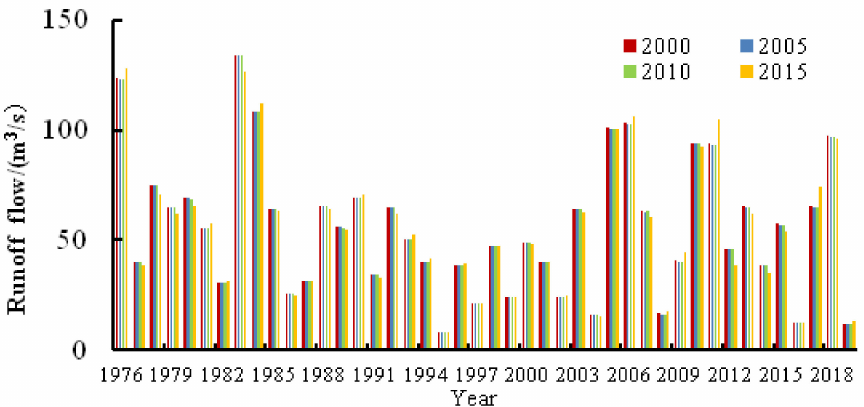
Figure 10. Change trends of simulated runoff changes in the land use context in different